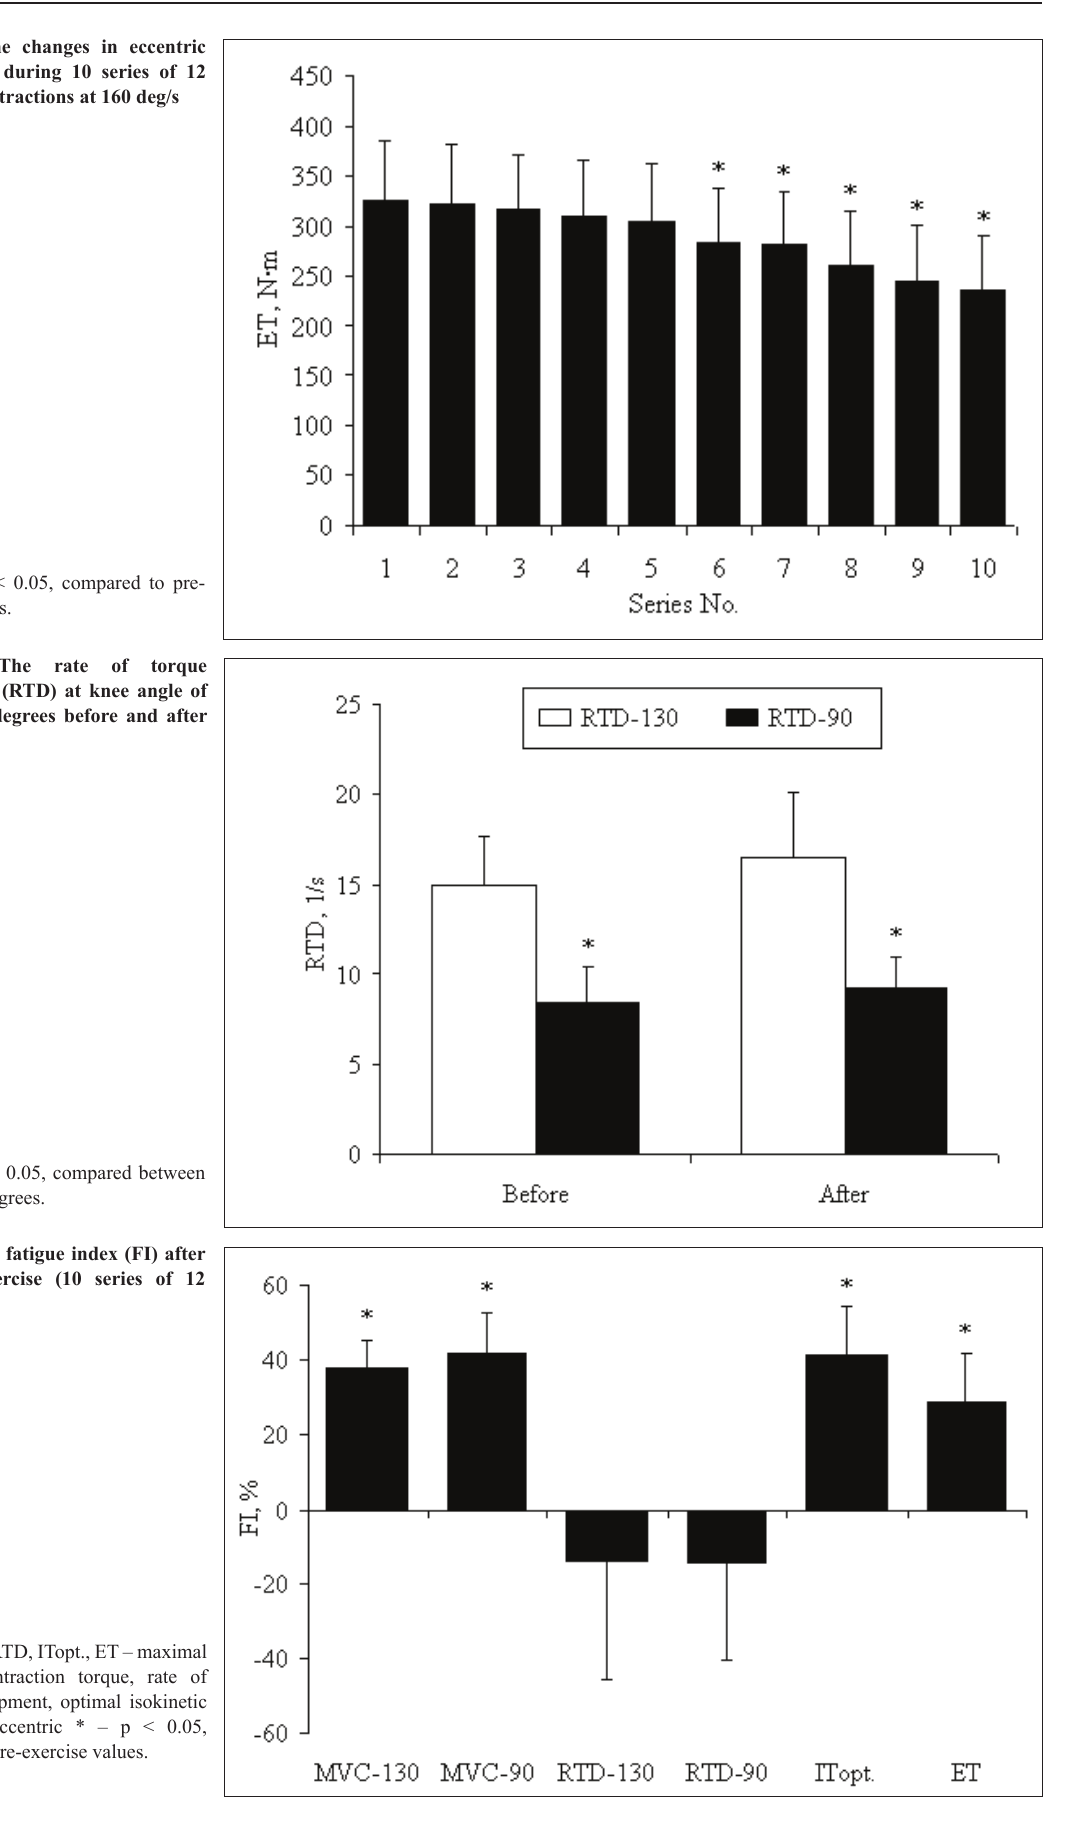
Figure 1. The changes in eccentric torque (ET) during 10 series of 12 eccentric contractions at 160 deg/s